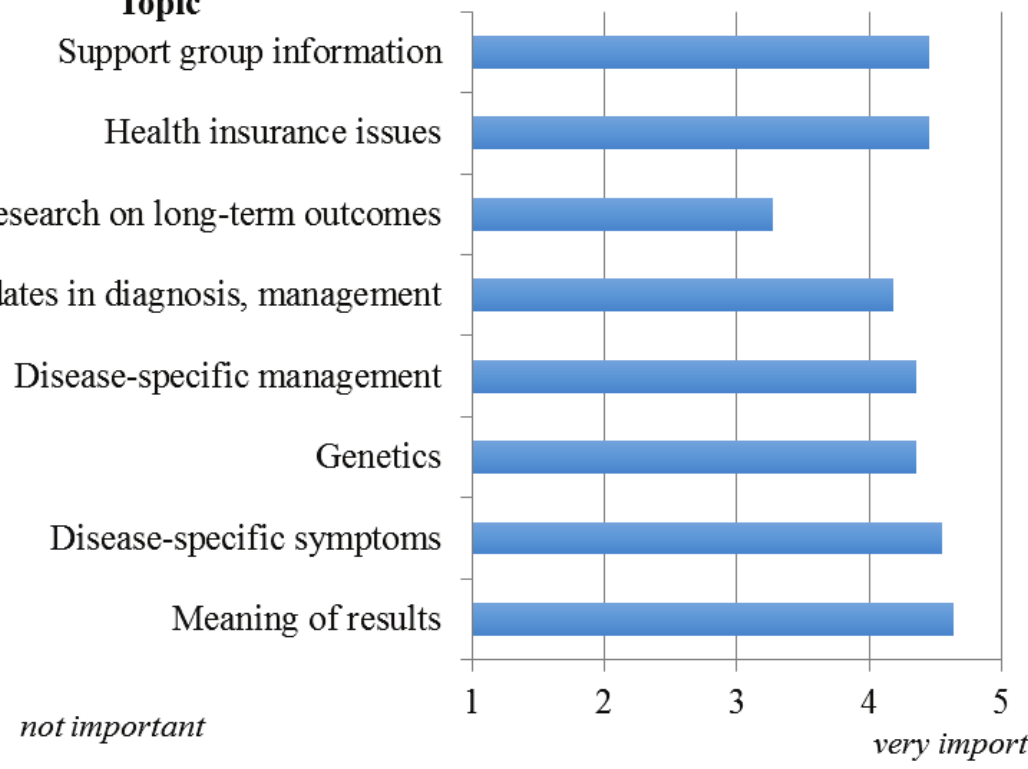
Figure 3. Importance of information to be provided to parents/families of infants with abnormal NBS